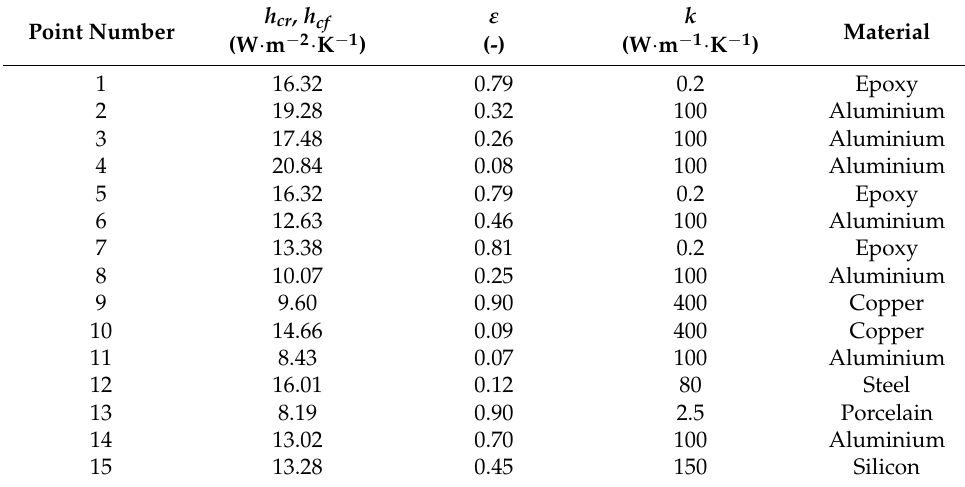
Table 2. Values of the convection coefficient for cylinder h cr , convection coefficient for the flat surface h cf , the value of emissivity coefficient ε , thermal conductivity value, and selected material used in the simulation, where the power dissipated on the P j junction was 5.48 W ( ∆ P j = 0.43 W).